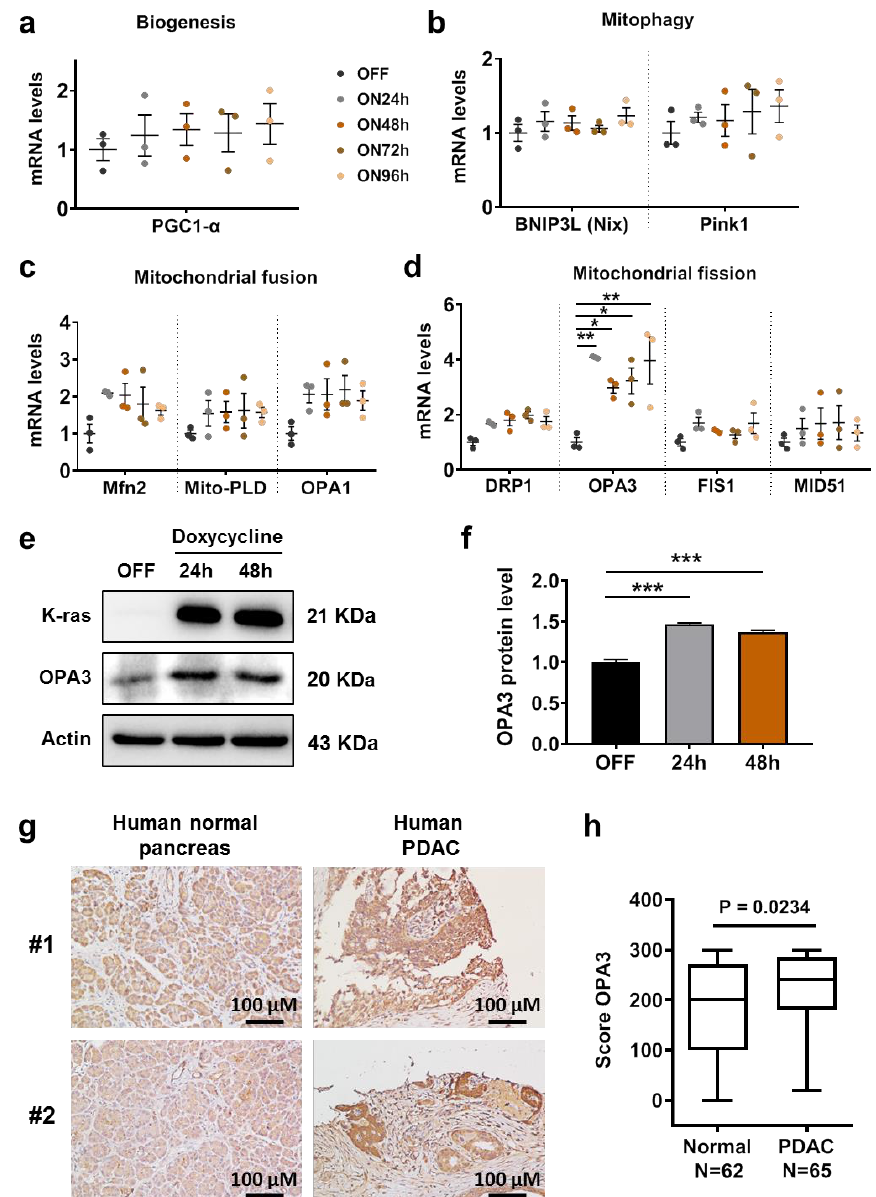
Figure 1. Oncogenic K-ras activation induces OPA3 expression in HPNE cells. Inducible K-ras G12D cell line was incubated with doxycycline for various incubation times. The mRNA levels of ( a ) biogenesis, ( b ) mitophagy, ( c ) mitochondrial fusion, and ( d ) mitochondrial fission genes were measured by real-time PCR. ( e , f ) Inducible K-ras G12D cell line was incubated with doxycycline for various incubation times. OPA3 protein levels were analyzed by immunoblotting and quantified. ( g ) Immunohistochemistry analysis for OPA3 in human normal and pancreatic (PDAC) tumor tissues. ( h ) Score of OPA3 staining, measured by immunohistochemistry IHC, in human normal and PDAC tumor tissues. Statistics: data are mean ± S.E.M, one-way ANOVA followed by Dunnett post hoc test (compared to “OFF”) for ( a – d ) and ( f ), and unpaired T-test for ( h ). * p < 0.05, ** p < 0.01, and *** p < 0.001. Abbreviations: BNIP3L (Nix): BCL2 interacting protein 3 like; Drp1: dynamin related protein 1; Fis1: mitochondrial fission 1 protein; Mfn2: mitofusin-2; HPNE: human pancreatic nestin expressing cells; K-ras: Kirsten RAS GTPase; MID51: mitochondrial dynamics proteins of 51 kDa; Mito-PLD: mitochondrial phospholipase D; OPA1: optic atrophy protein 1; OPA3: optic atrophy protein 3; PDAC: pancreatic ductal adenocarcinoma; PGC-1 α : peroxisome proliferator-activated receptor gamma coactivator 1-alpha; and Pink1: PTEN induced kinase